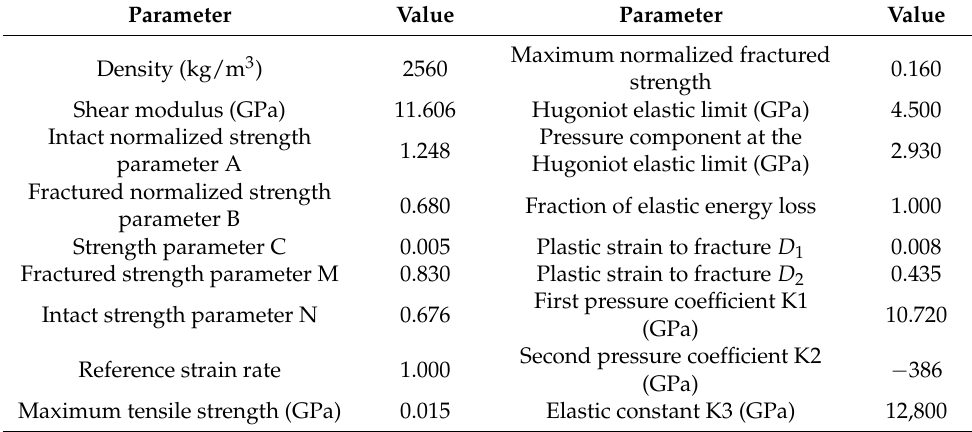
Table 1. Input parameters of the JH-2